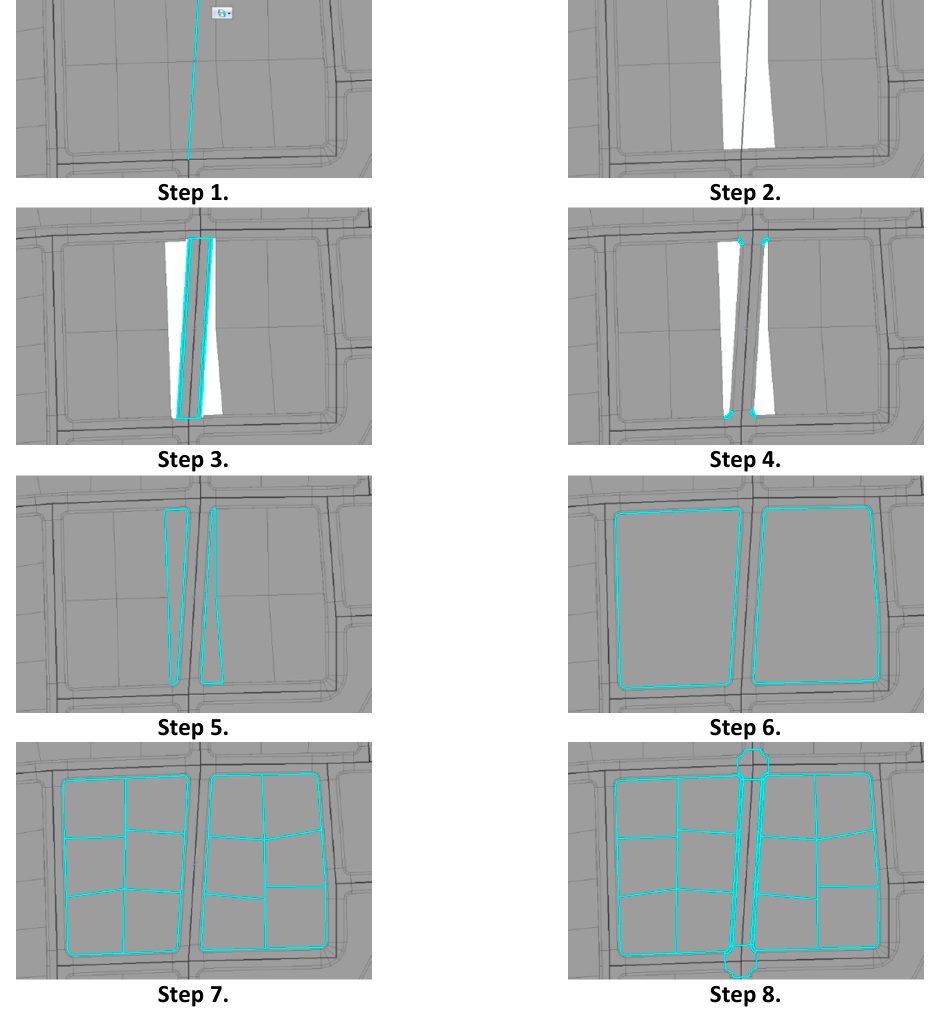
Figure 7. The existing procedure for installing a new road.